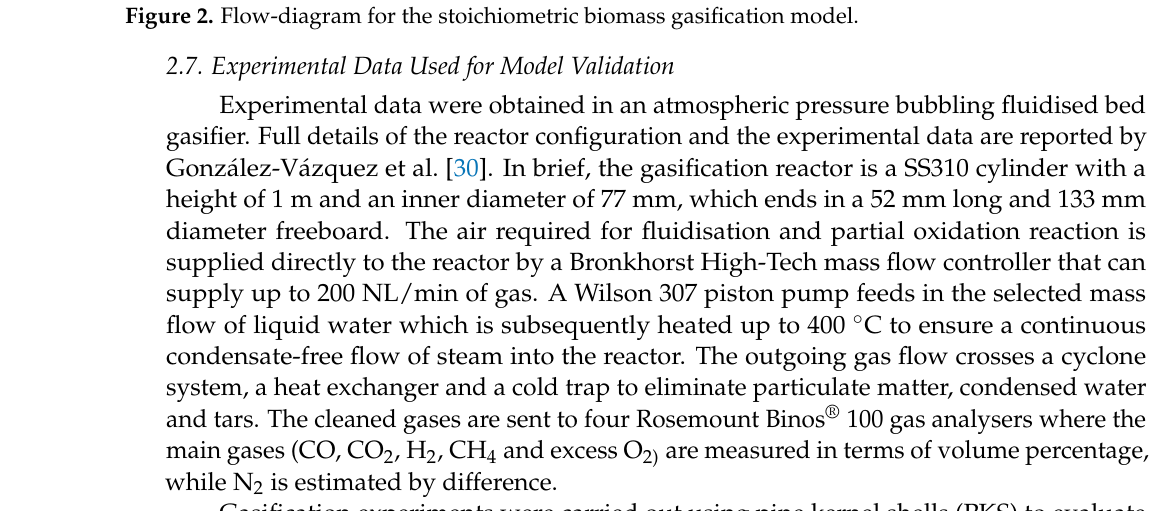
Figure 2. Flow-diagram for the stoichiometric biomass gasification model.